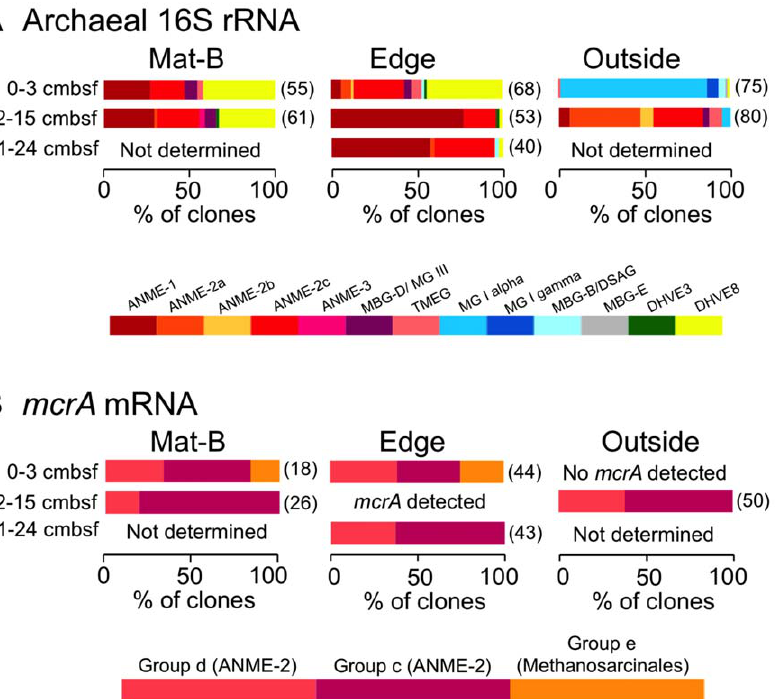
Figure 4. Archaeal community structure and stratification. Phylogenetic affiliations of (A) archaeal 16S rRNA and (B) mcrA mRNA transcripts at different depths across the mat transect. In A), shades of red and orange denote putative methane-oxidizing or methane-producing groups. Numbers in parentheses are the total number of clones analyzed including full length and short reads. ‘‘Not determined’’ means that no amplification was tried; ‘‘ mcrA detected’’ means that mcrA was amplified but not sequenced.